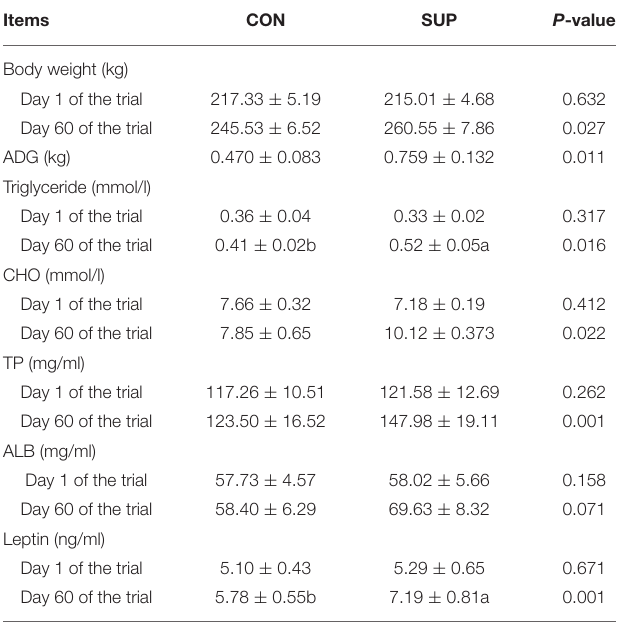
TABLE 2 | Effects of concentrate supplementation on body weight and blood indices of grazing